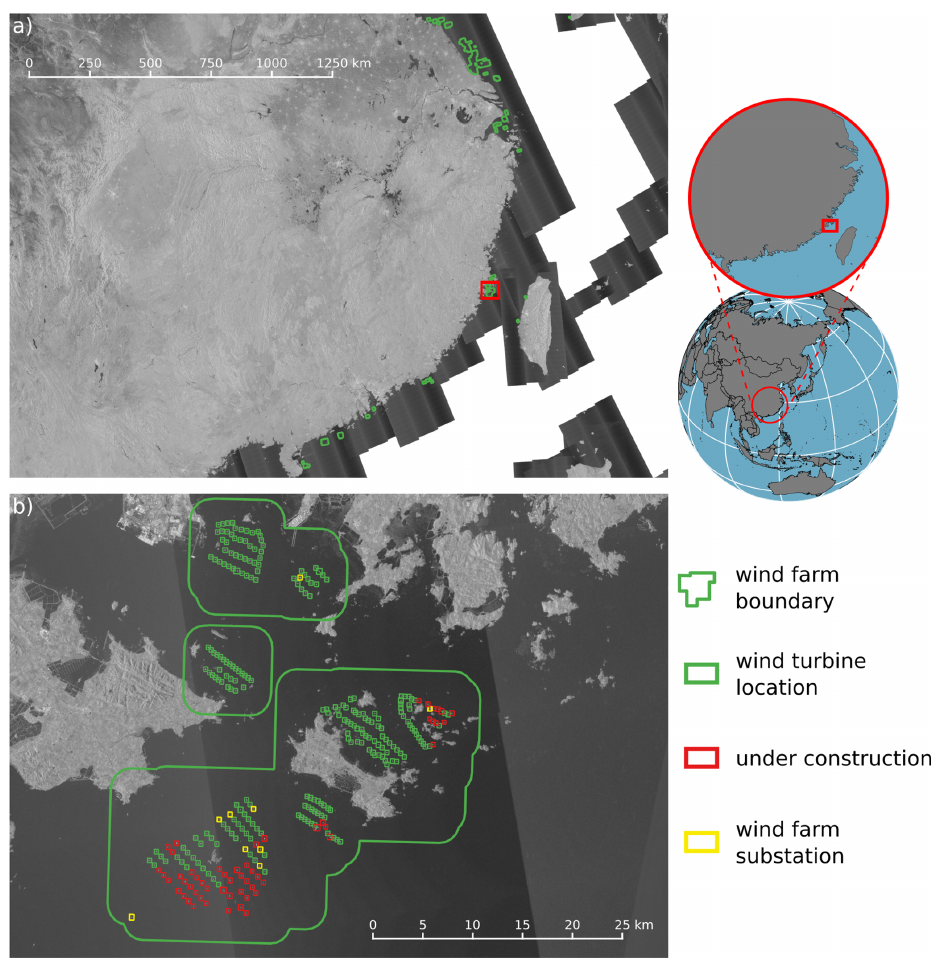
Figure 5. Detection results of the CNN cascade for the South and East China seas. Panel (a) shows the OWFs detected by stage 1, and panel (b) shows the OWTs, OWF substations, and such under construction detected by stage 2 within the OWF boundaries of stage 1 in the Taiwan